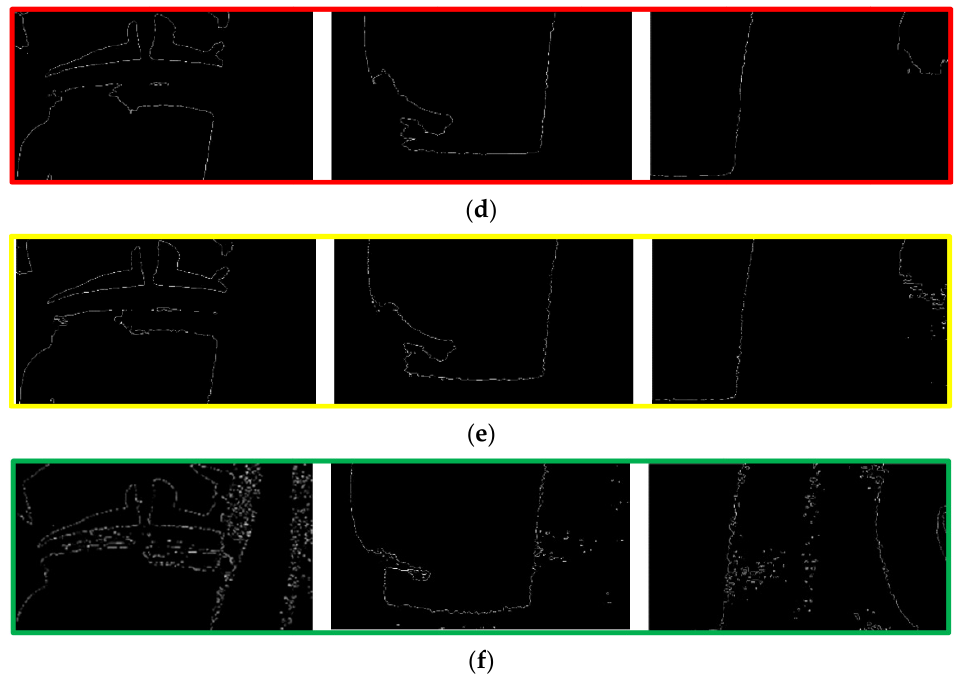
Figure 11. Comparison results of the reconstructed view images. ( a ) The enlarged image of Figure 10a; ( b ) the enlarged image of Figure 10b; ( c ) the enlarged image of Figure 10c; ( d ) the outline extraction of ( a ); ( e ) the outline extraction of ( b ); ( f ) the outline extraction of ( c ). Table 2. Image quality comparison